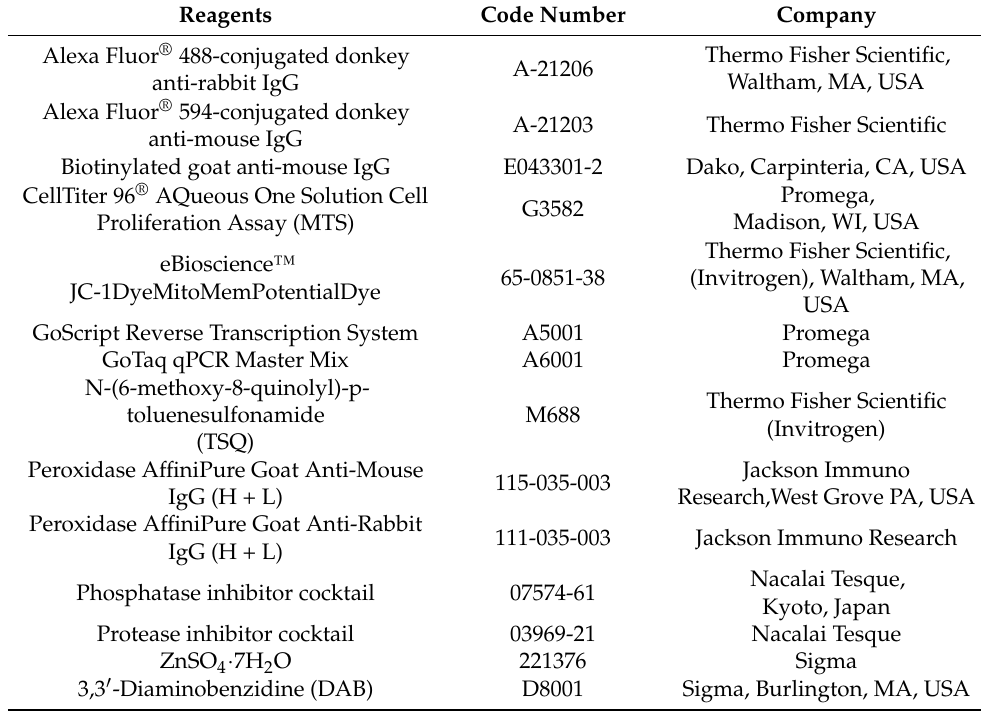
Table 1. List of